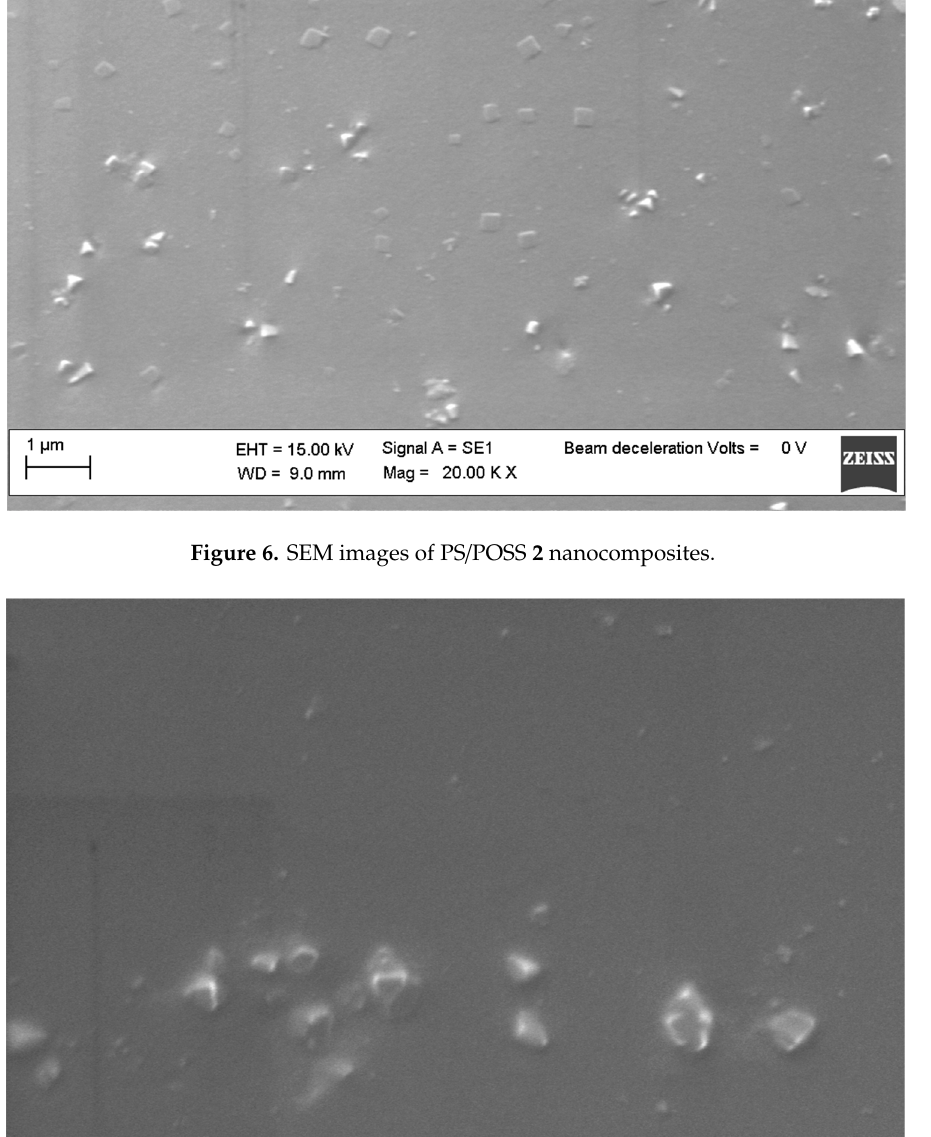
Figure 8. Differential thermogravimetric curves, in an inert atmosphere, for PS and samples 1 , 2 and 3 .